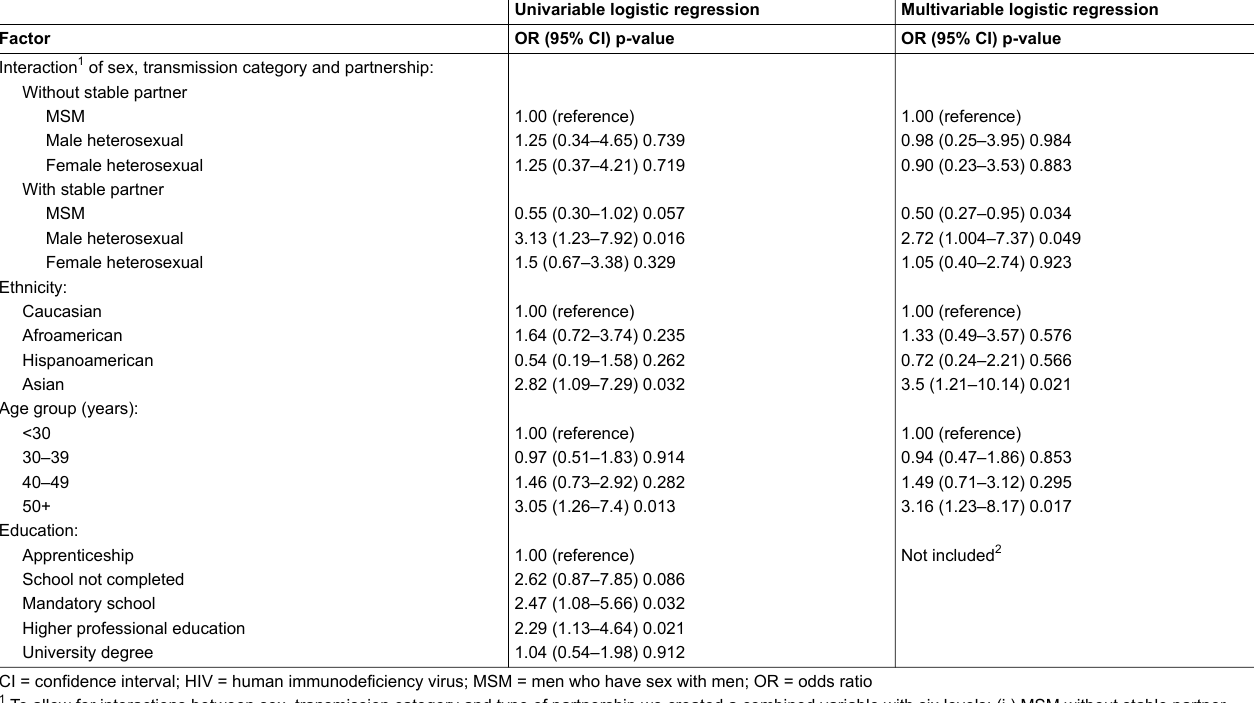
Table 2: Logistic regression analyses of cofactors associated with late presentation (n = 116) compared with the combined groups of not late presentation and acute HIV infection (n = 149). Persons infected via injection drug use (n = 8) and other routes (n = 8) were